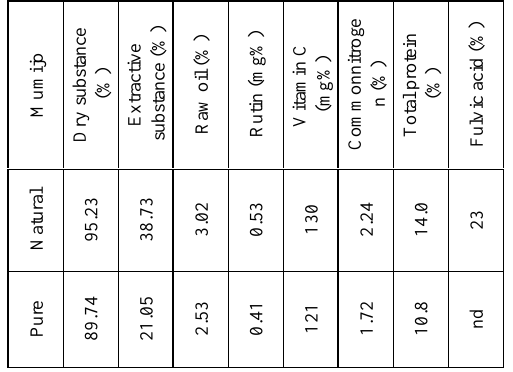
Table 2. Some results of biochemical characteristics of natural and pure